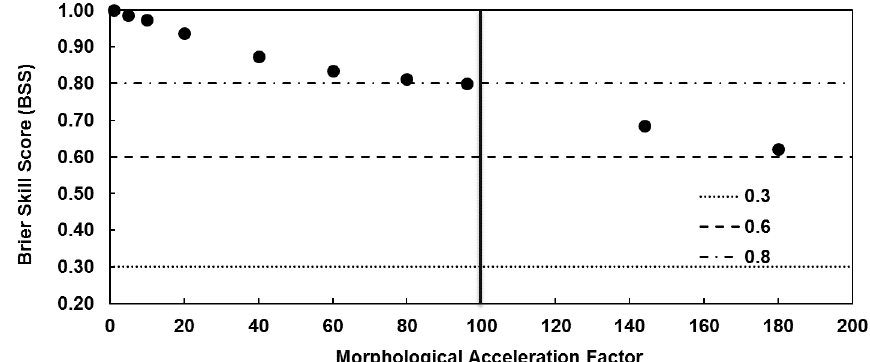
Figure 2. Assessment of acceleration factor (MORFAC) on morphological changes.